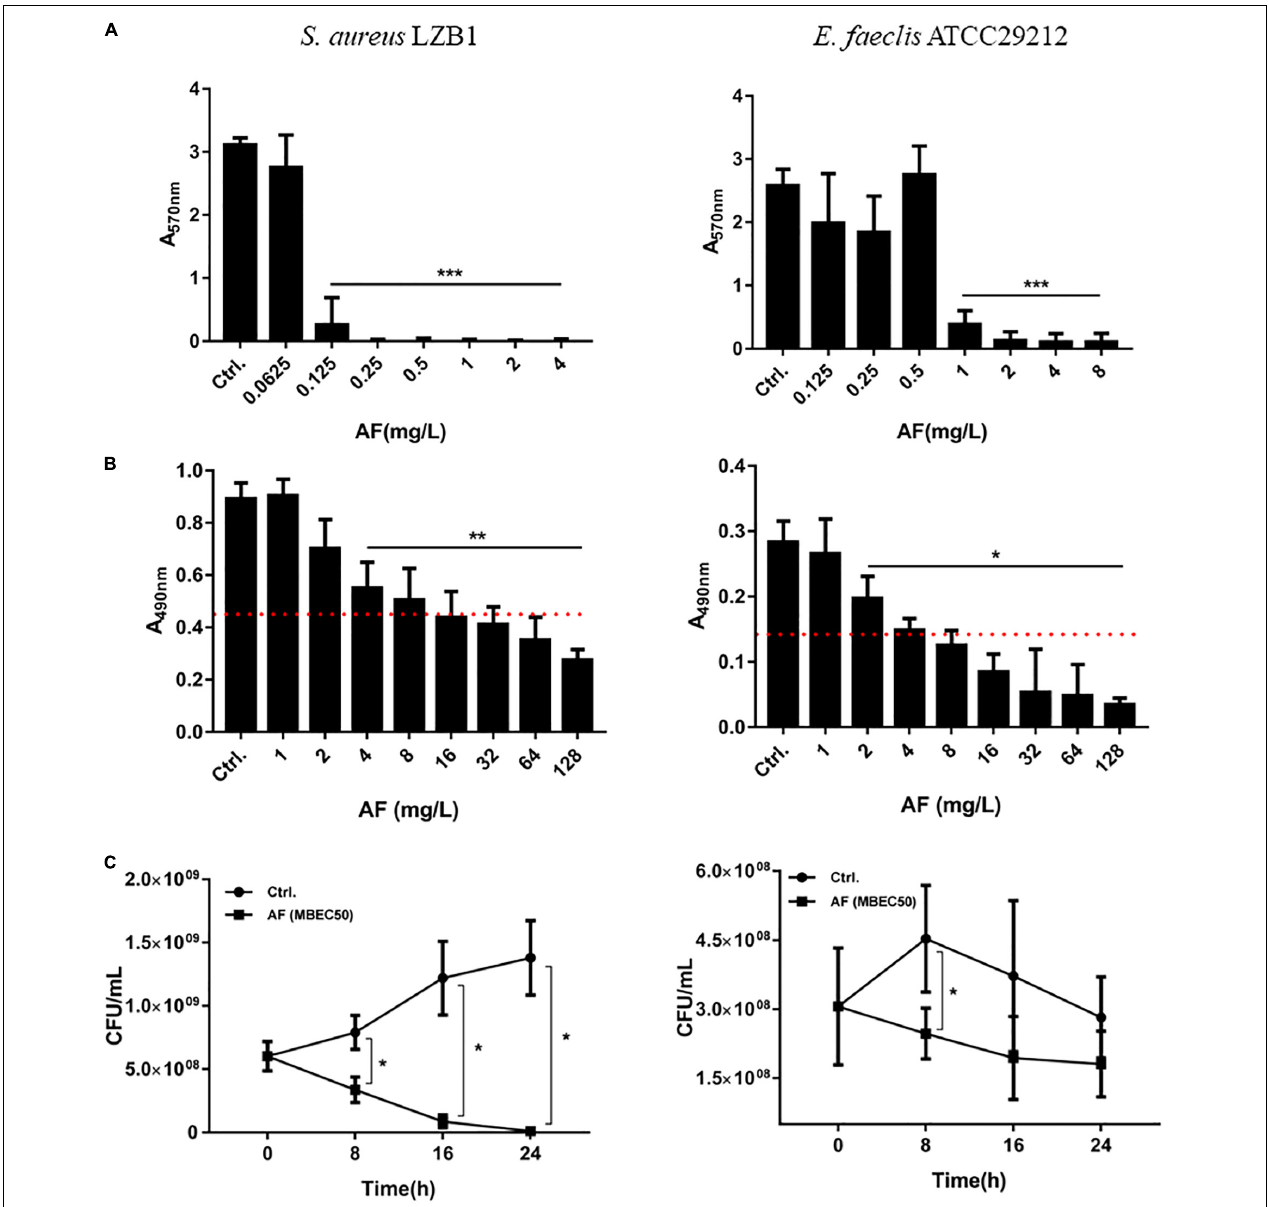
FIGURE 1 | Antibiofilm effects of AF on Staphylococcus aureus LZB1 and Enterococcus faecalis ATCC29212. (A) Biofilm inhibitory effect determination by CV staining. Overnight cultures of strains were diluted with AF to the designated concentrations. After 24 h incubation, planktonic cells were removed and stained with 0.25% CV. (B) Biofilm eradication by AF detected by XTT staining. Biofilms grown for 24 h were treated with AF at the designated concentrations. After incubation, planktonic cells were removed and stained with a solution of XTT/PMS. The red dashed line indicates 50% of the biofilm biomass of the control group. (C) Live cell counts. Twenty-four hour biofilms were treated with AF at a concentration of MBEC50 for 24 h, and serial dilutions and plate counts were performed to determine the live cells in the biofilms ( ∗ p < 0.05; ∗∗ p < 0.01; ∗∗∗ p <